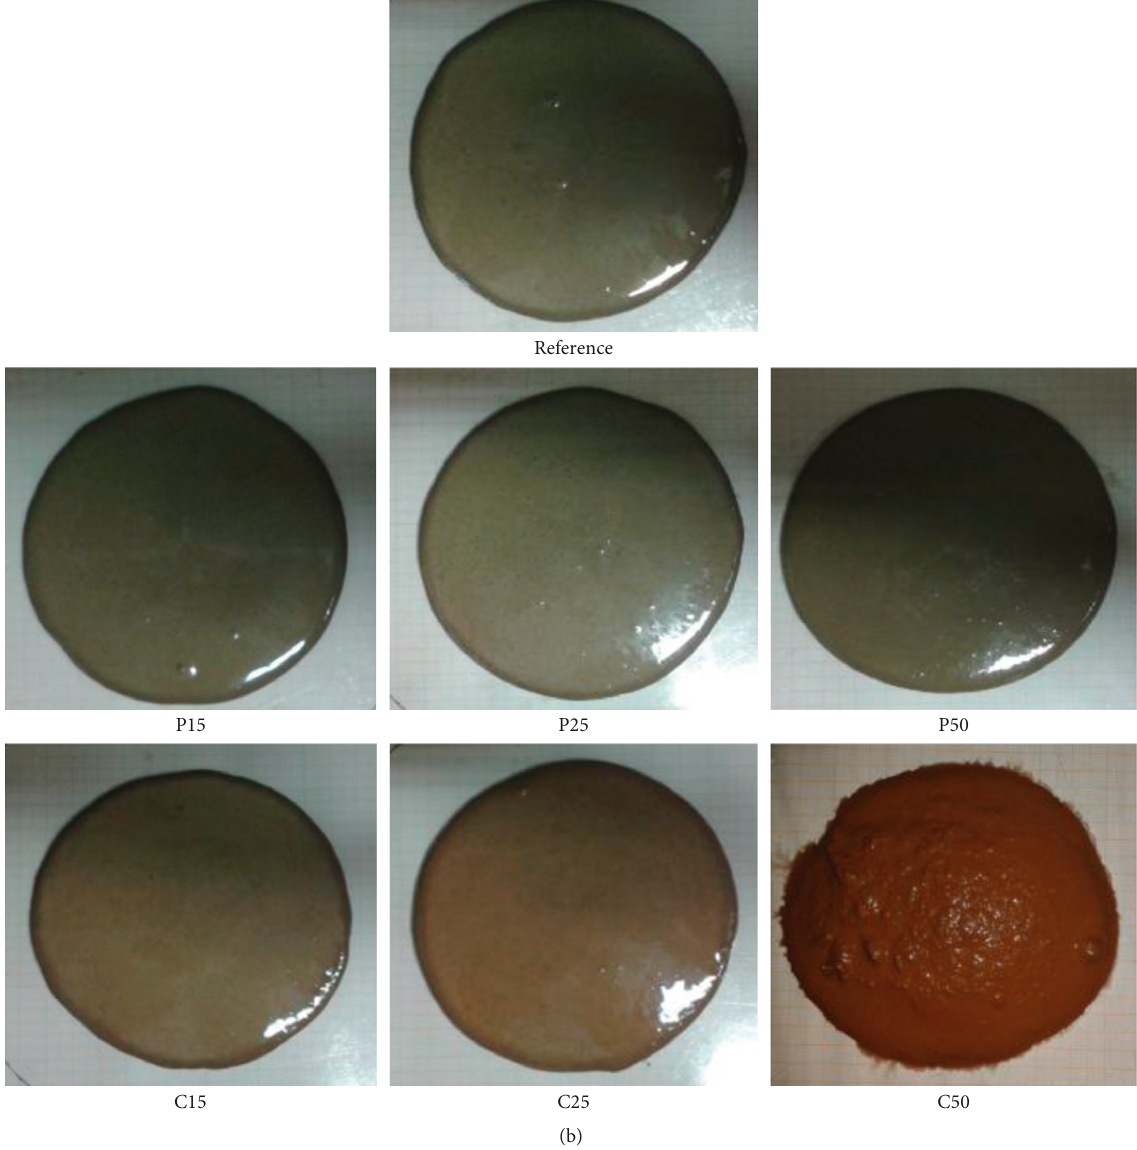
Figure 6: Spread diameter images of SLM. (a) Spanish Cylinder tests; (b) Kantro’s Cone